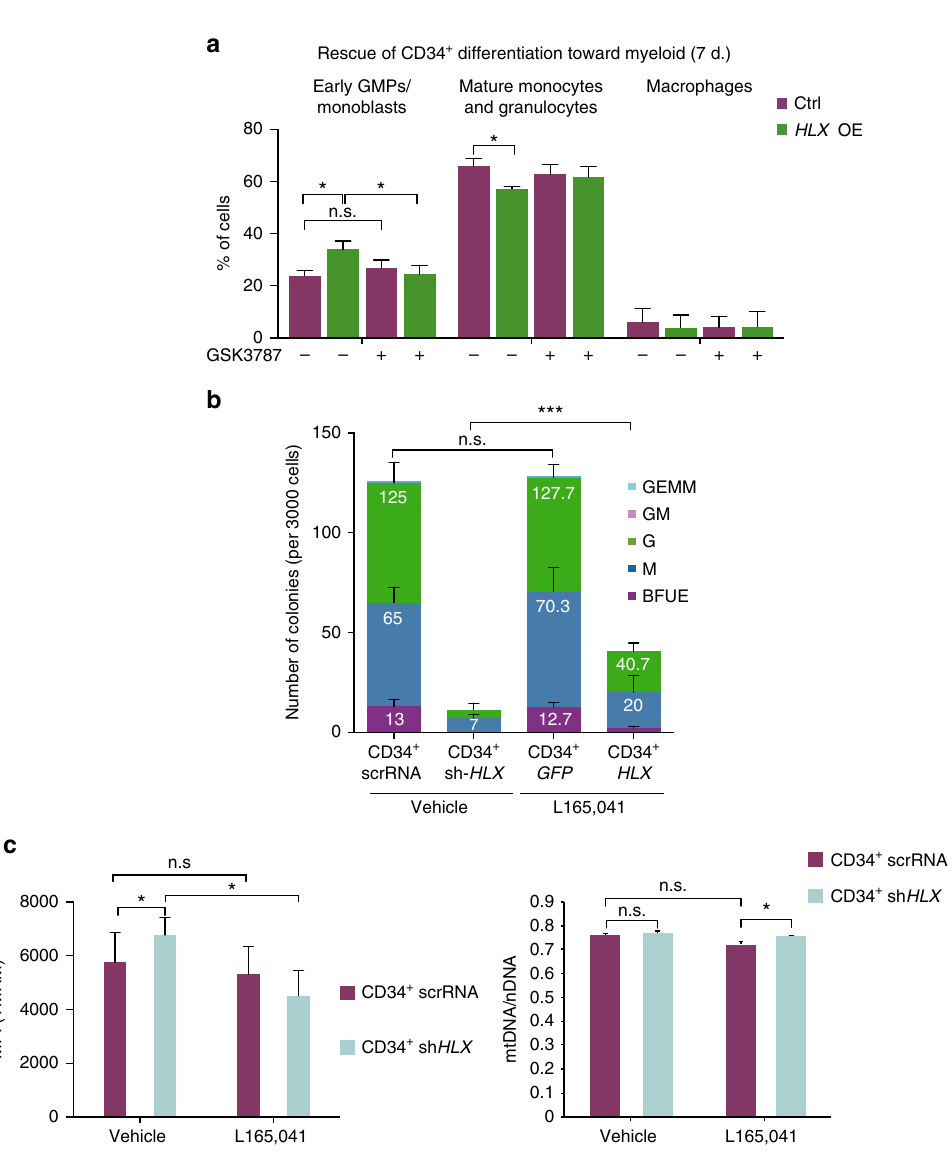
Fig. 7 PPAR δ modulation rescues hematopoietic phenotypes in human primary cells. a Flow cytometric analysis of CD34 + GFP or CD34 + HLX cells cultured in differentiation media for 7 days in the presence or absence of the PPAR δ antagonist GSK3787 depicts rescue of the myeloid differentiation block after treatment ( n = 3, Student ’ s t -test, * P < 0.05, mean + s.d.). b Average number of colonies in CFU-C assays performed in CD34 + cells infected with control scrRNA or sh- HLX , treated or not with L165,041 ( n = 2, three technical replicates each time, mean + s.d., Student ’ s t -test, *** P < 0.001). c Mitochondrial membrane potential measured by TMRM (left panel) and respective mitochondria vs. nuclear DNA ratio (right panel), in CD34 + infected with scrRNA or sh- HLX treated or not with L165,041 ( n = 3, mean + s.d., Student ’ s t -test, * P < 0.05)